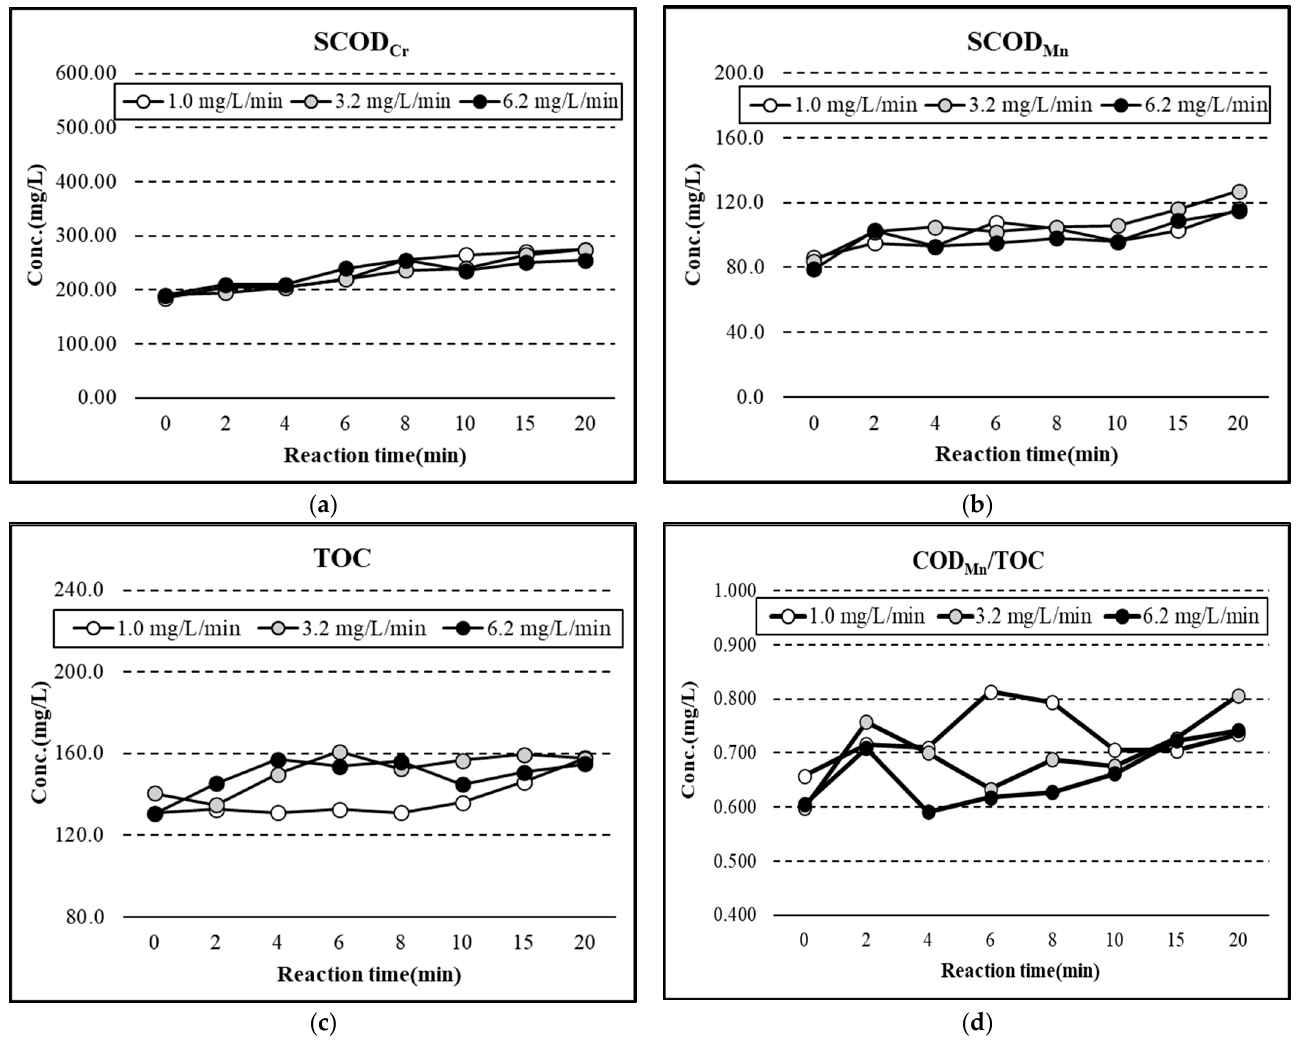
Figure 2. Effect of ozone feed rate on (a) SCOD Cr , ( b ) COD Mn , ( c ) TOC, and ( d ) COD Mn /TOC . Figure 2b indicates that during the ozone dosing from 1.0 to 6.2 mg/L/min, the